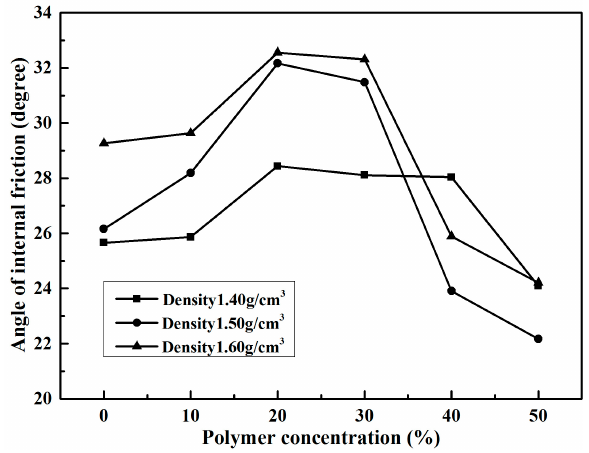
Figure 10. The variations of internal friction angle of reinforced specimens with polymer concentration.